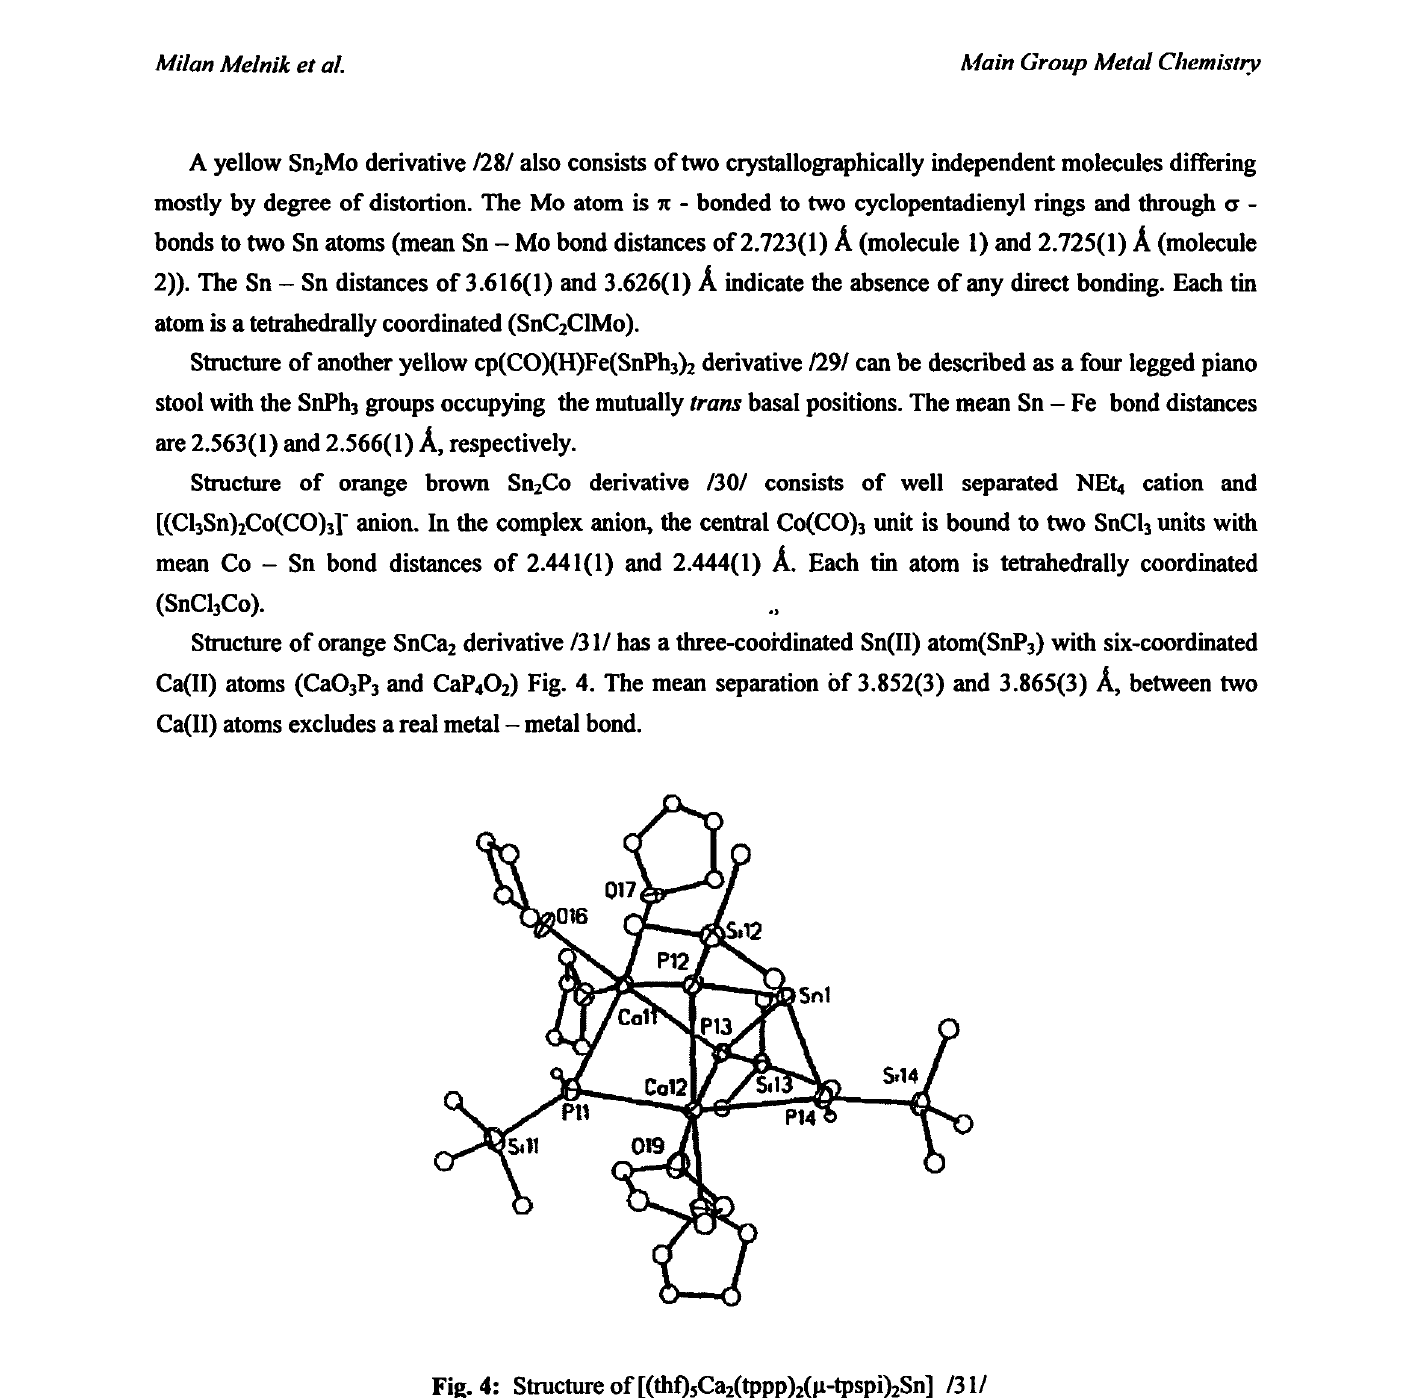
Fig. 4: Structure of [(thf)jCa